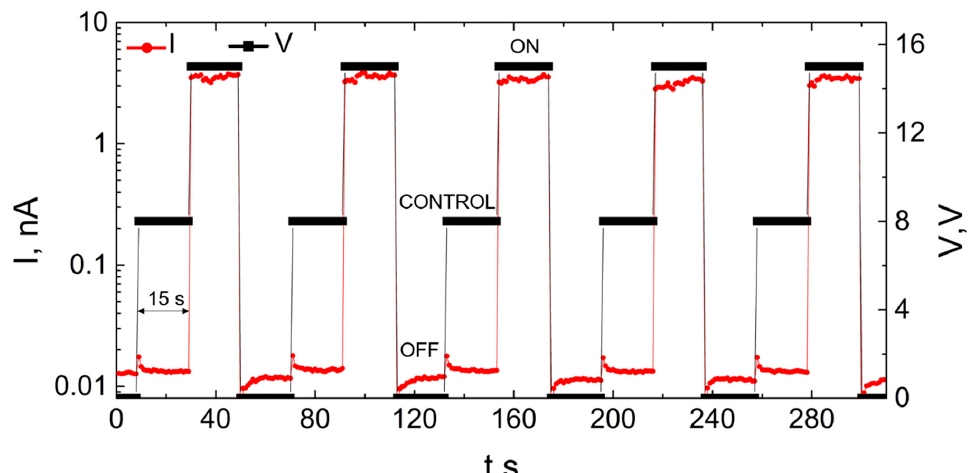
Figure 7. Variation of NEM switch current levels (red circles) at different applied voltages (black squares) of 0 V (OFF), 8 V (OFF, control), 15 V (ON) during repeatable switching. For 0 V and 8 V, the current stays at the noise level, whereas ON current reaches nA level, when applied voltage is 15 V.